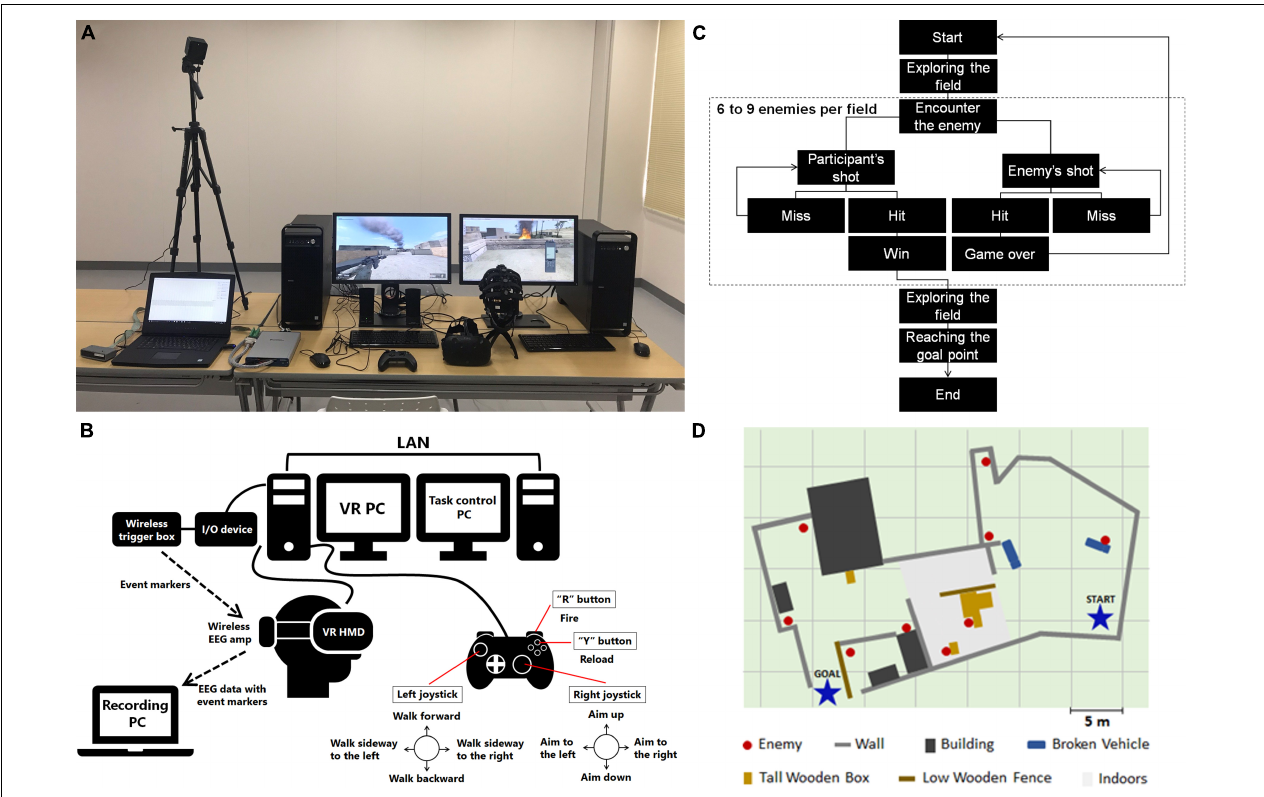
FIGURE 1 | Details of the experiment environment. (A) System setup. (B) Schematic representation of VR system with EEG recording system. In the experiment, experimenter selected and initiated the task scenario with task control PC. Participants performed the task using gamepad with the VR PC. When task-related events occur, the VR PC sends event markers to the wireless trigger box via the I/O device. The wireless EEG amp receives the event markers and sends raw EEG data with event markers to the recording PC wirelessly. (C) Flow of events in a scenario. (D) Sample map of a